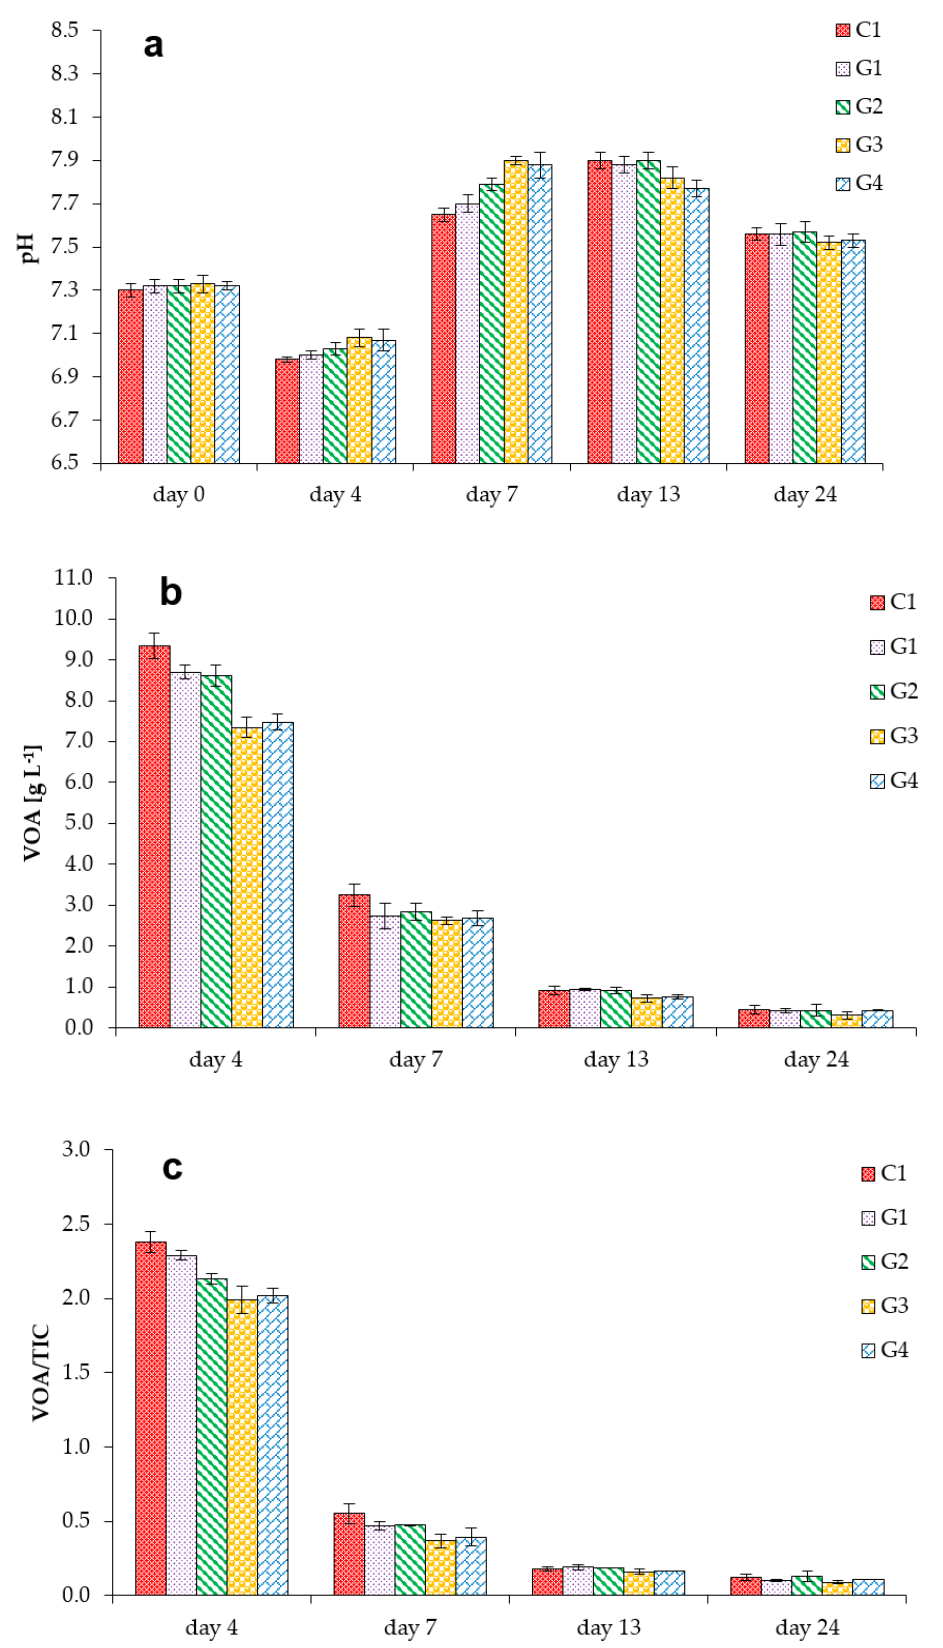
Figure 2. E ff ects of GAC addition on pH changes ( a ), VOA concentrations ( b ), and the ratio of volatile organic acids to total inorganic carbon (VOA/TIC) ( c ) during the experimental period (ISR is 1.43). Di ff erent concentrations of GAC (0 g L − 1 , 1 g L − 1 , 2 g L − 1 , 5 g L − 1 , and 10 g L − 1 ) were added to reactors (C1, G1, G2, G3, and G4,